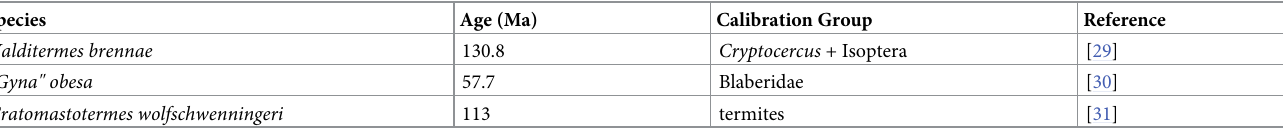
Table 2. Fossils used for estimation of divergence time of Numts in the analysis.